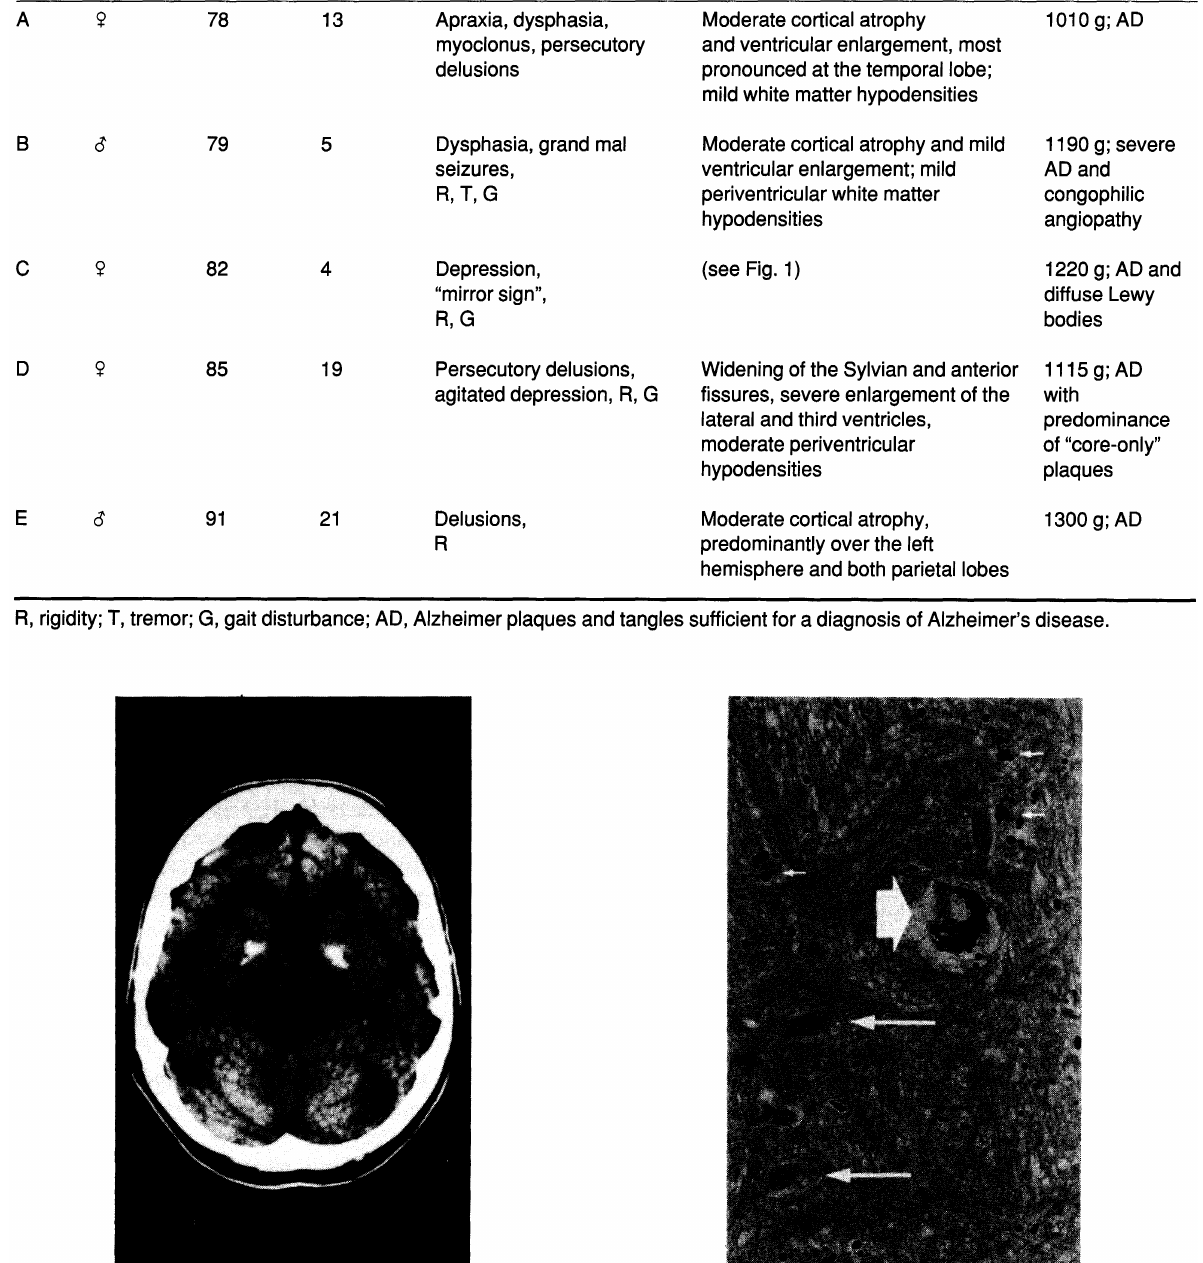
FIG. 2. Large neurons (long arrows), small vessel (broad arrow) and capillary mineralization (small arrows) in the pallidum internum (patient C; H&E stain; magnification x 400). the middle of the night. She neglected herself and did not eat well. Her memory deteriorated at age 80. She tended to forget appointments and lose her handbag. At night she